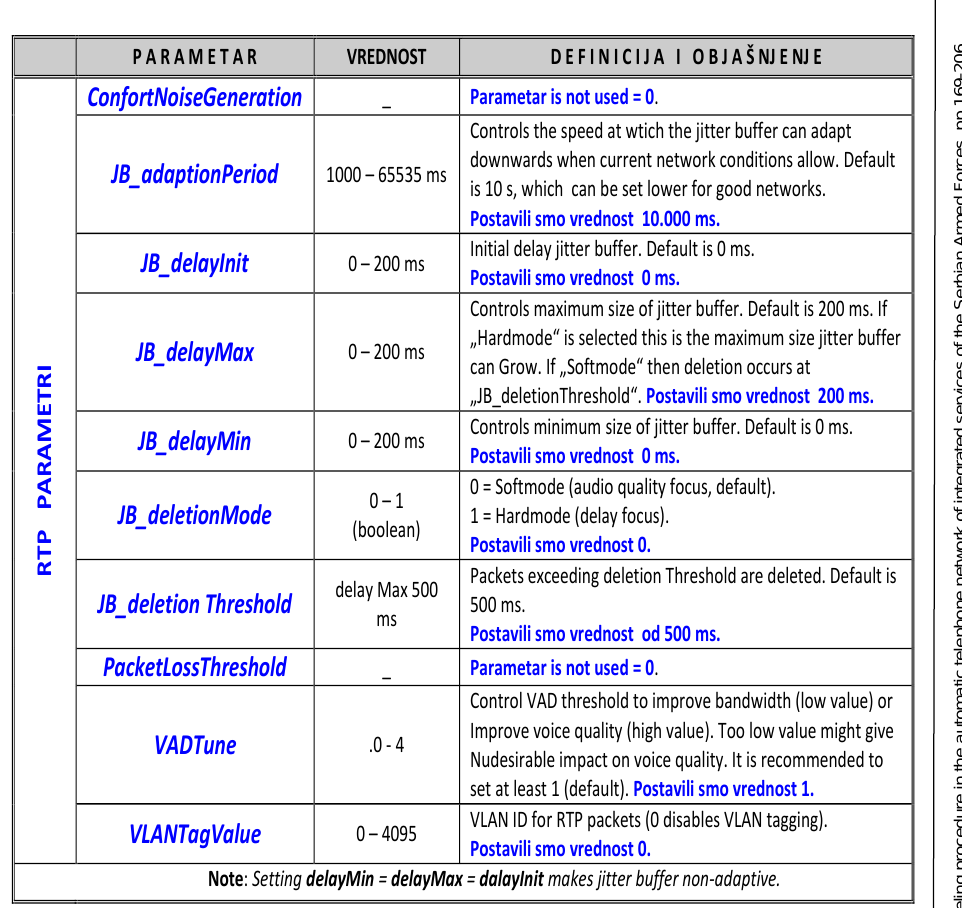
Figure 8 – Set parameters and their values to reduce the impact of jitter on RTP packets (Svrzić, 2019; Svrzić et al, 2019b) Рис. 8 – Установленные параметры и их значения для снижения влияния джиттера на пакеты RTP (Svrzić, 2019; Svrzić et al, 2019b) Слика 8 – Постављени параметари и њихове вредности за смањење утицаја џитера на RTP пакетима (Svrzić, 2019; Svrzić et al,